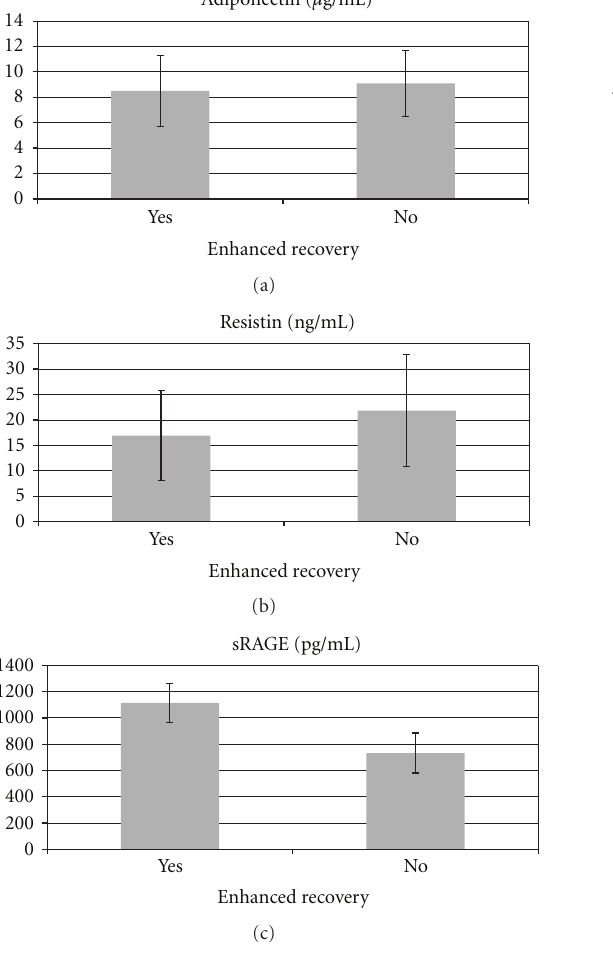
Figure 4: Mean values of serum adiponectin, resistin, and